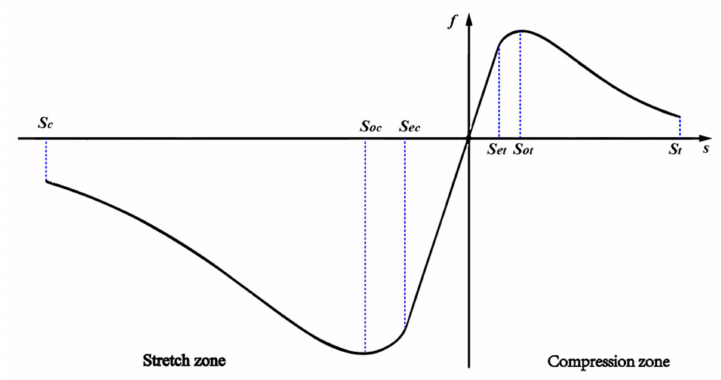
Figure 2. The relationship between the force density vector f and the elongation S